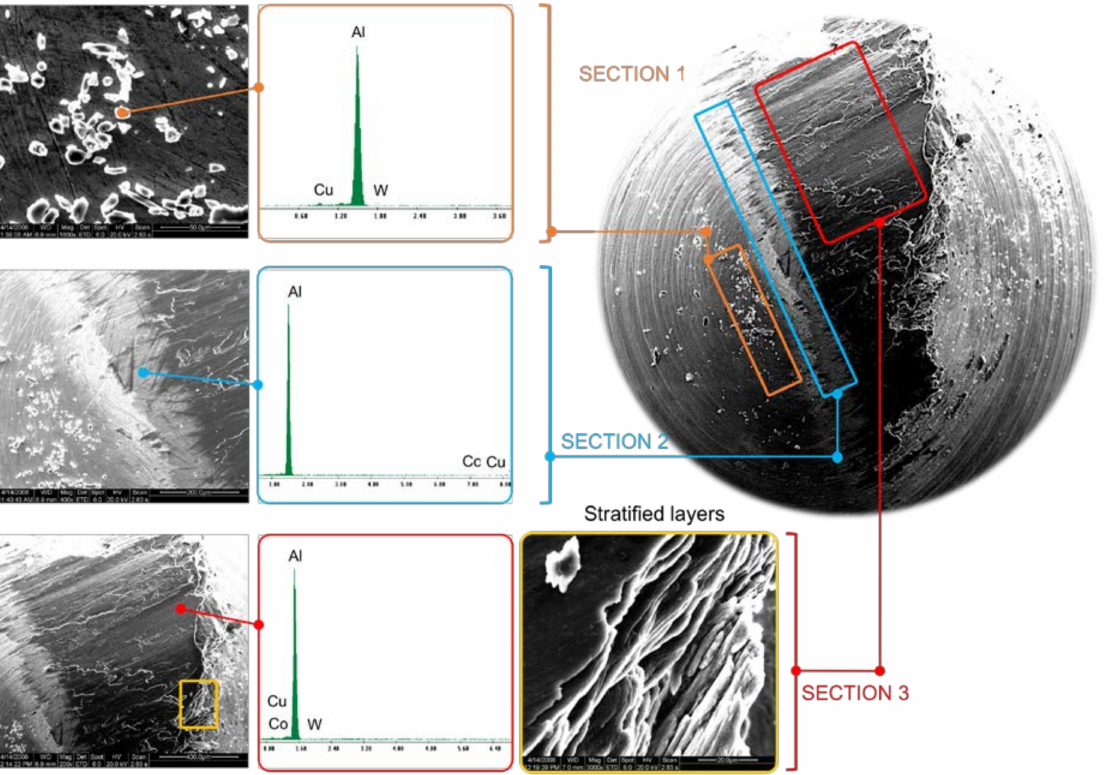
Figure 7. SEM (100 × ) micrography of the Pin for test 500 m sliding distance. Detailed areas for the adhesion and punctual Energy Dispersion Spectroscopy (EDS) of the different wear